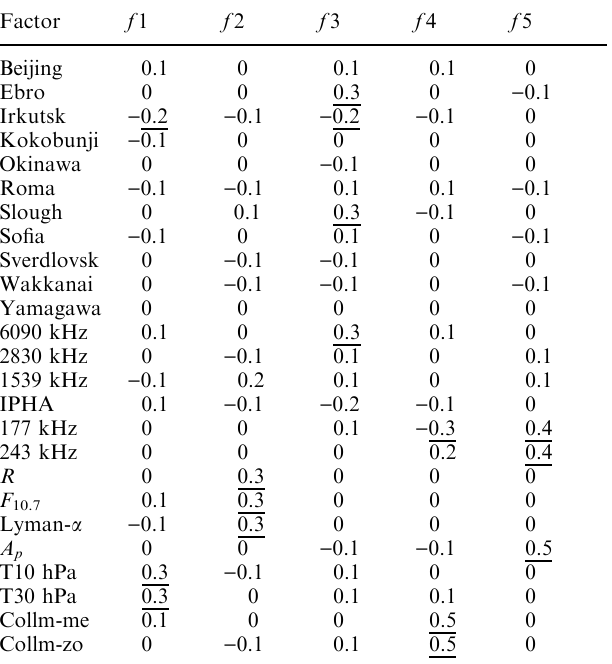
Table 8. PCA factor scores after varimax axis rotation and transformation for October–November 1994, all parameters studied, the first five factors. Important scores are